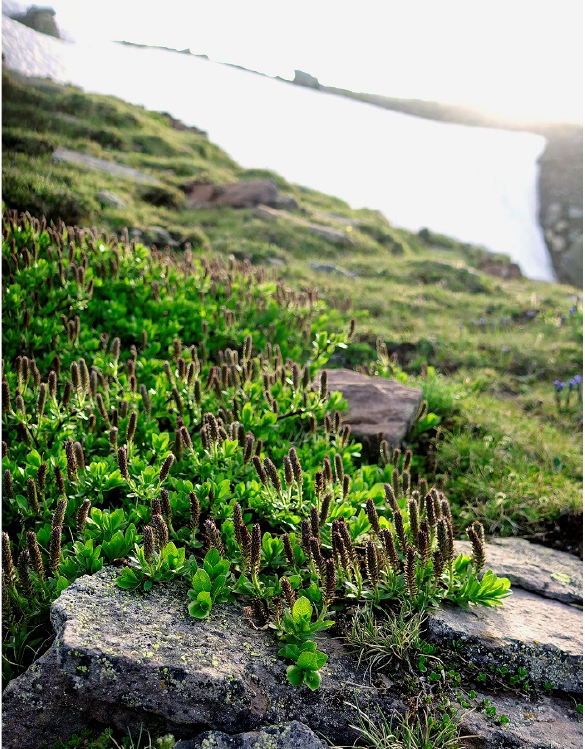
Figure 2. Alchemillo alpinae-Salicetum breviserratae of the Orotemperate acidophilous belt in High Campoo District (summit area of Valdecebollas, Celada de Roblecedo, Palencia).